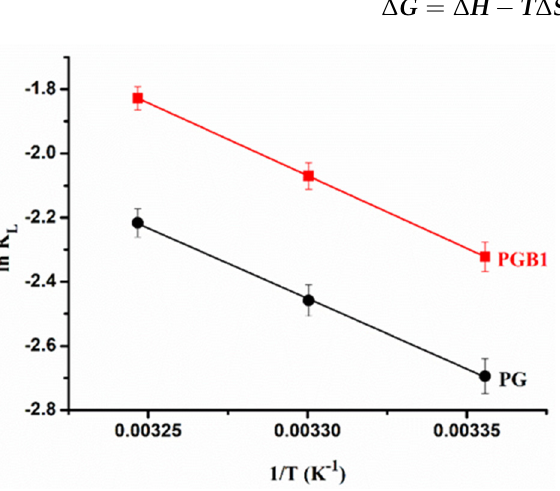
Figure 12. Plots of ln K L versus 1/ T for sorption of 1,2,4-triazole derivative onto PG and PGB1 copolymers. Table 4. Thermodynamic parameters of sorption process .